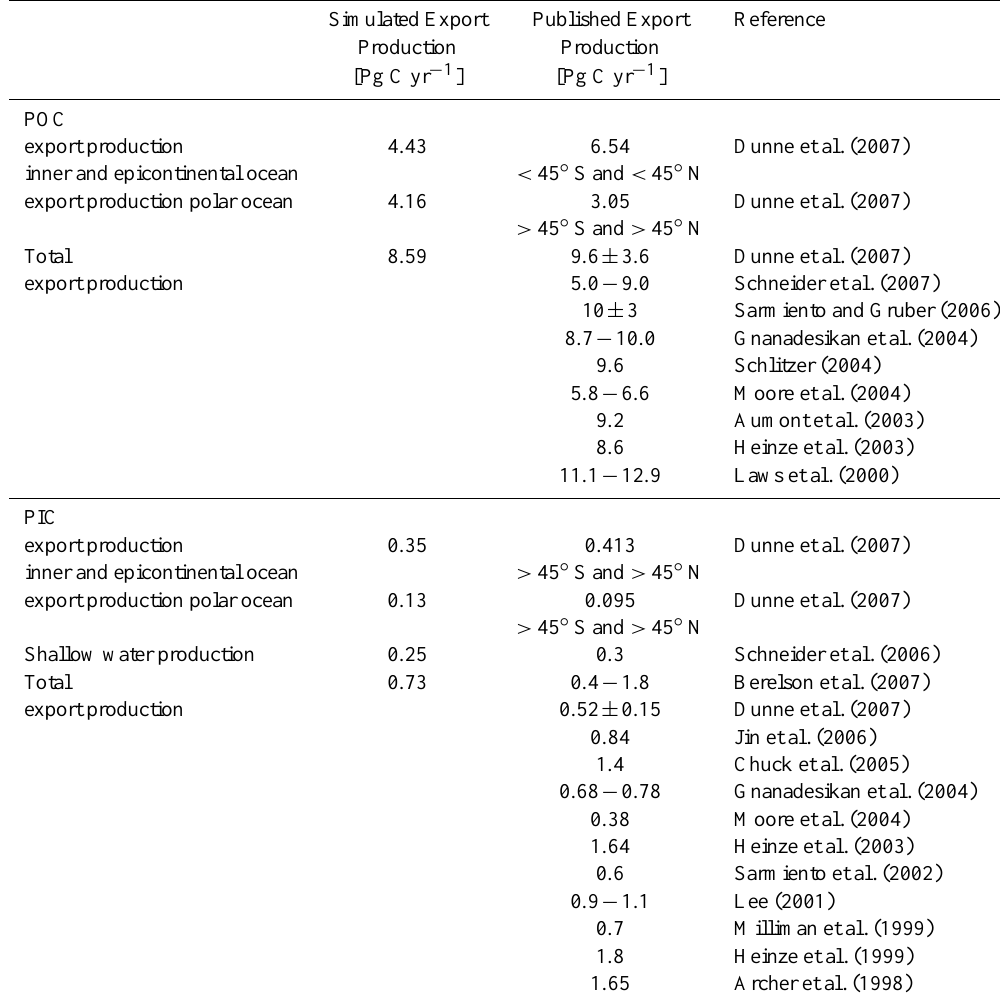
Table 10. Simulated and published estimates of ocean export